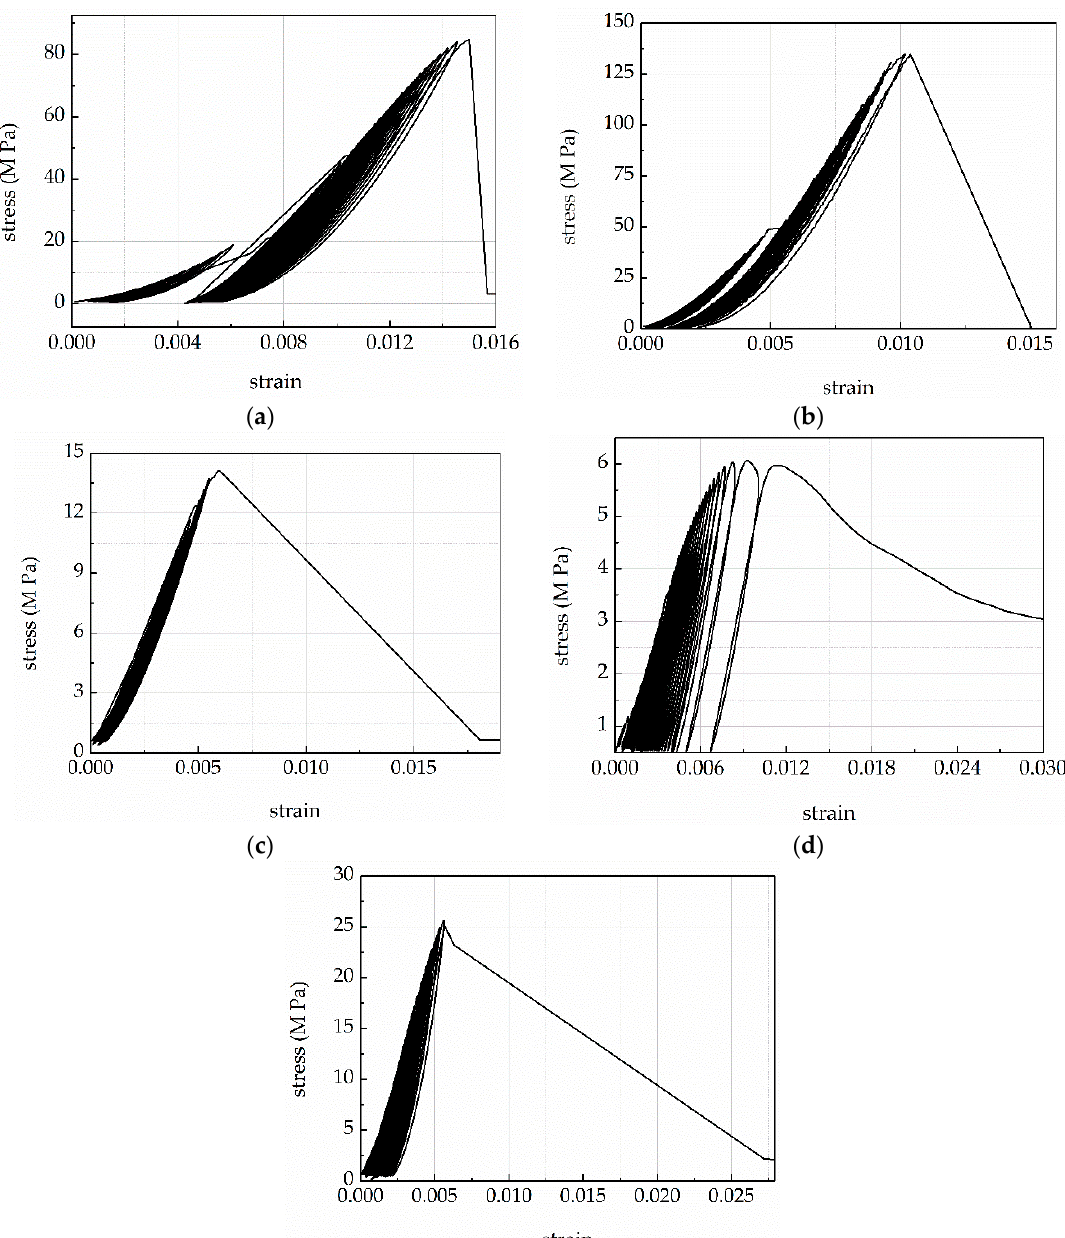
Figure 5. Stress–strain curves of uniaxial cyclic experiments for different rocks. ( a ) Red sandstone, ( b ) granite, ( c ) coal, ( d ) high-water material, and ( e ) gypsum.